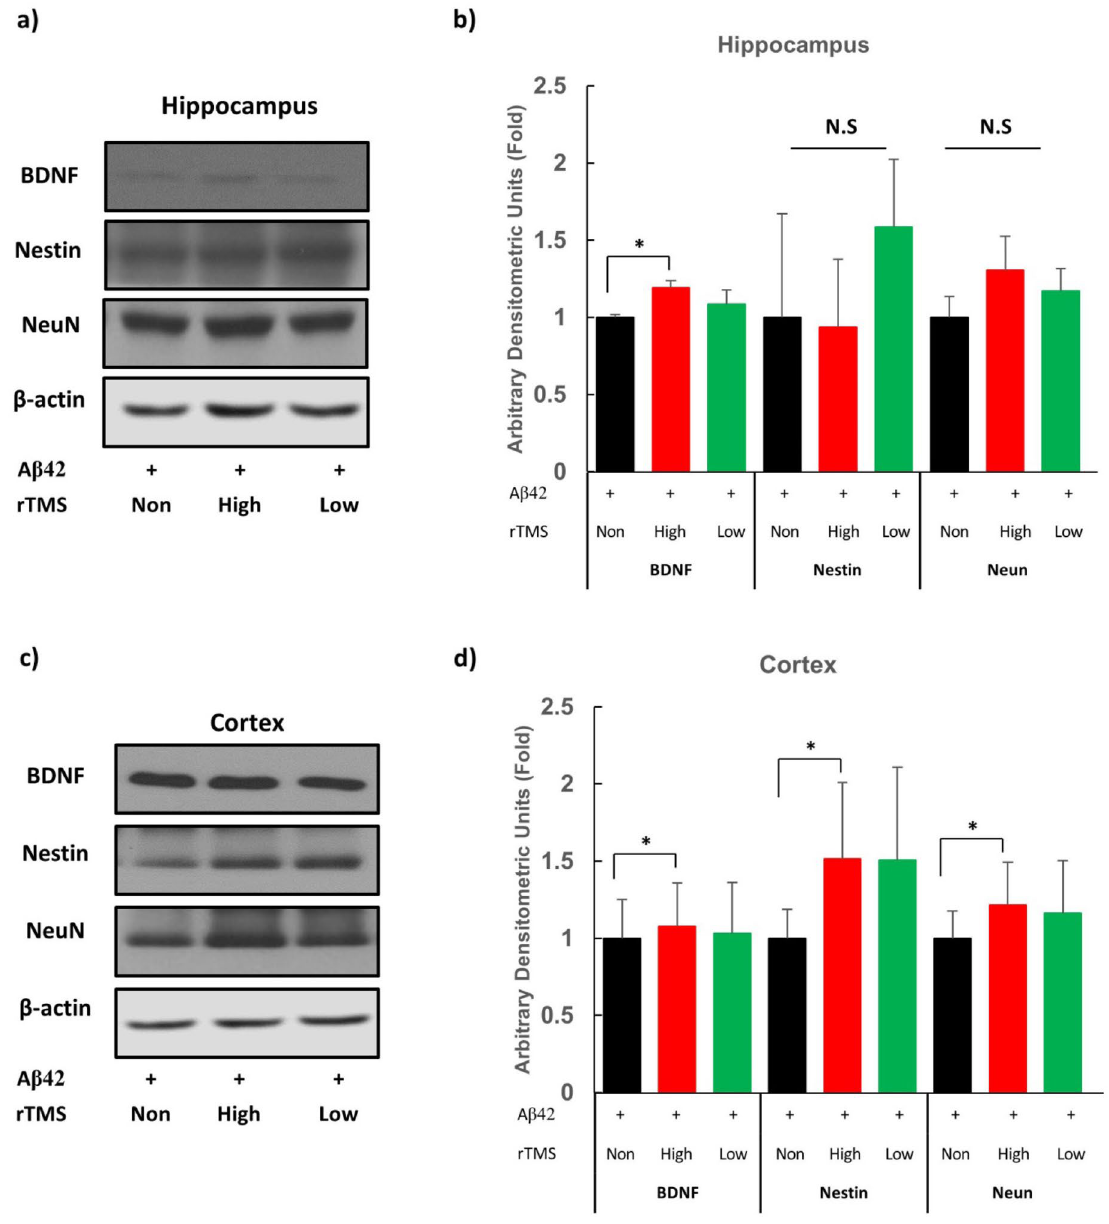
Figure 4. rTMS upregulates neurogenic expressions in AD mouse model. ( a ) Protein expression of hippocampal BDNF, Nestin and NeuN protein was measured by western blot. ( b ) Histograms show densitometry analysis of the western blot in hippocampus. ( c ) Protein expression of cortex BDNF, Nestin and NeuN protein was determined by the western blot. ( d ) Histograms show densitometry analysis of the western blot in cerebral cortex. Protein level of actin was analysed as a loading control. Mean data normalised to β-actin are in bar graphs compared with control. Each group n = 4, mean ± SEM.* Ps < 0.05. + Aβ42 oligomer injected via ICV, rTMS repetitive transcranial magnetic stimulation, AD Alzheimer’s Disease, BDNF brain-derived neurotrophic factor, Aβ42 amyloid beta 42 oligomer, None none treatment, High high frequency rTMS treated, Low low frequency rTMS treated, N.S. not